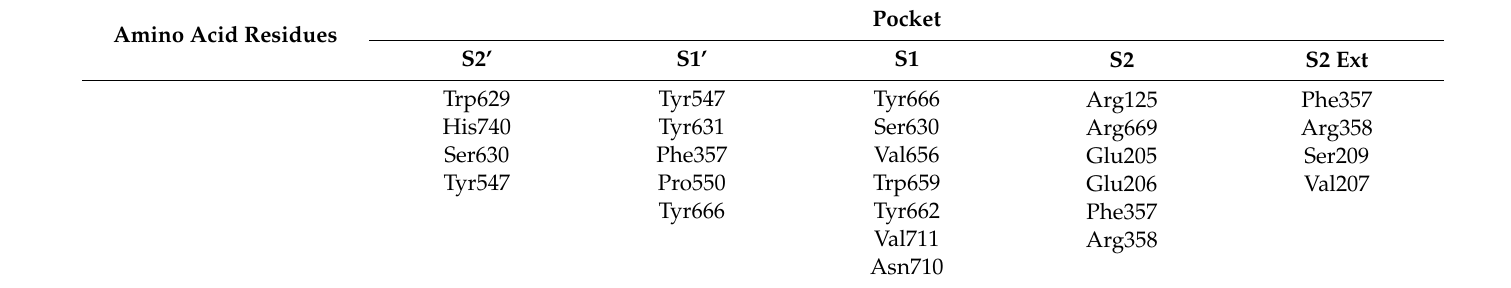
Table 2. Amino acid residues in the active site of the DPP-4 enzyme [28].